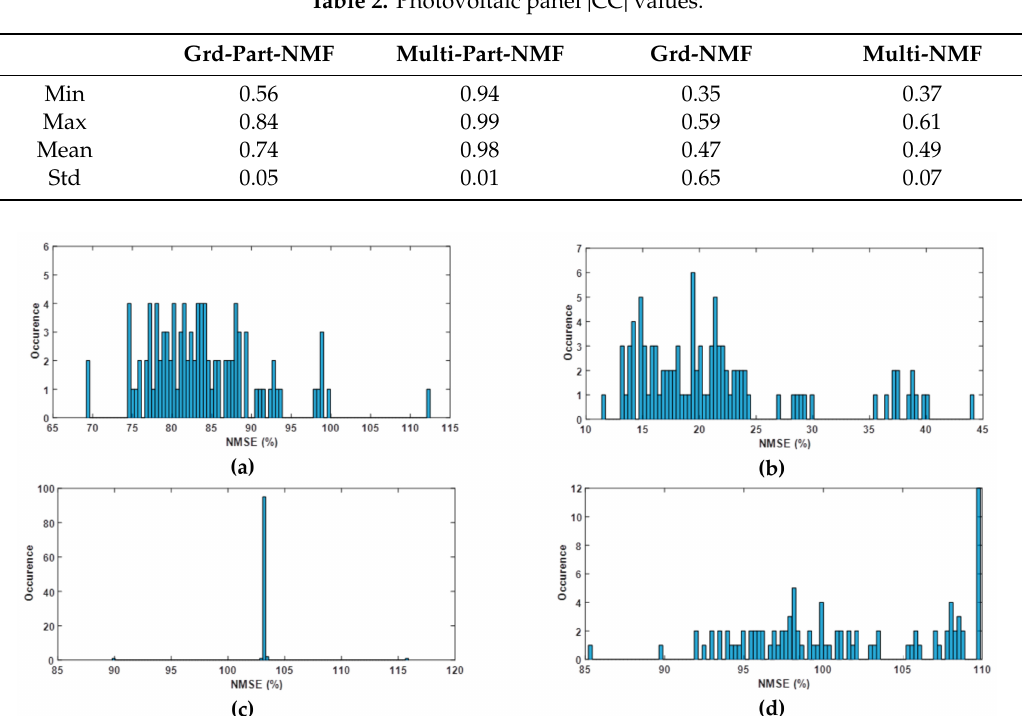
Figure 8. Histograms of the NMSE criterion values (%) obtained by the tested methods: ( a ) Grd-Part-NMF, ( b ) Multi-Part-NMF, ( c ) Grd-NMF and ( d )